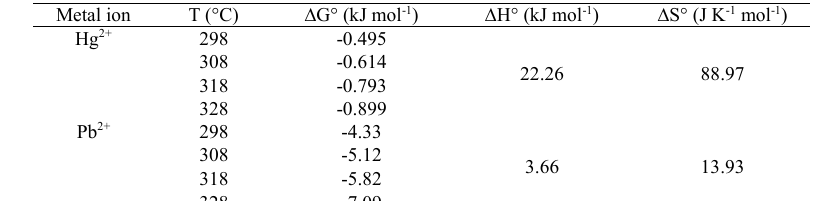
Table 5. Adsorption thermodynamic data.